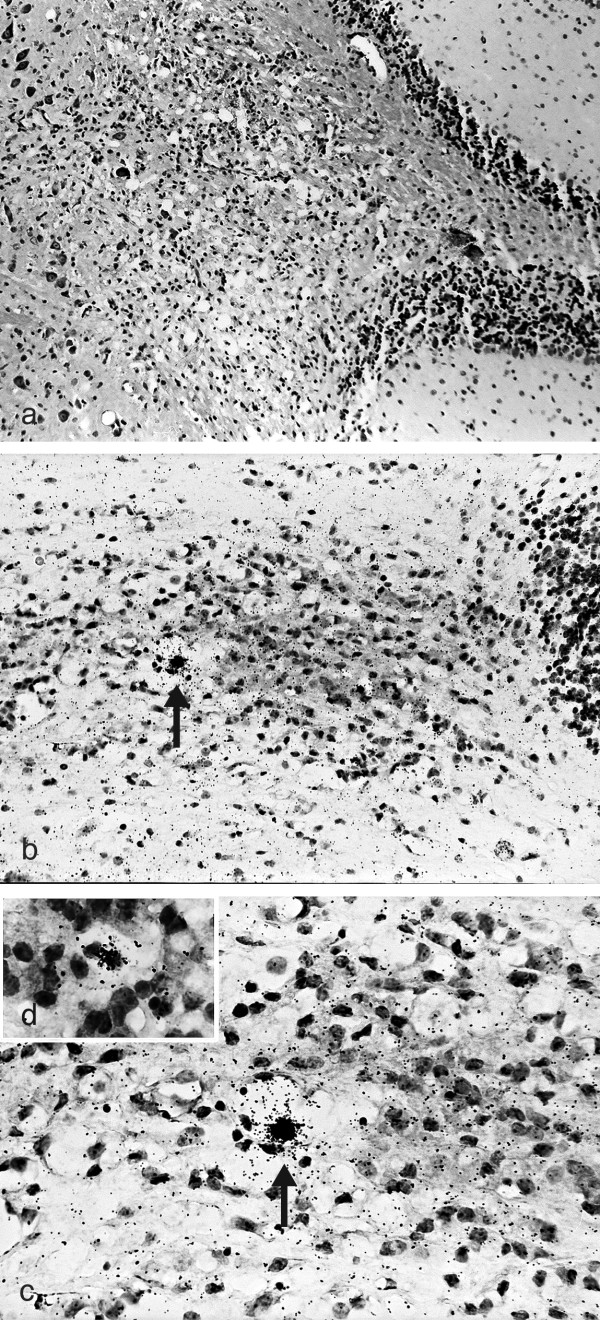
HSV-1 DNA positive cells remain in an area of demyelination following the clearance of viral antigen. 35S-labelled HSV-1 DNA positive cells can remain in demyelinating lesions of 10-12 week ♀SJL/J, A/J, and PL/J mice infected with virus via the oral mucosa. Adjacent serial sections were examined by ISH and histology. In representative sections from the CB of HSV-1 infected PL/J mice (a) demyelinating lesion are identified, 26 days PI, (x100), LFB-CFV while adjacent sections identify (b) HSV-1 DNA positive cells (arrow), 26 days PI, (x200), ISH counterstained with H & E. (c) Higher power photo-micrograph of HSV-1 DNA positive cells (arrow), 26 days PI, (x400), ISH/H & E. (d) High power photo-micrograph of HSV-1 DNA positive cell, 26 days PI (x1000), ISH/H & E.